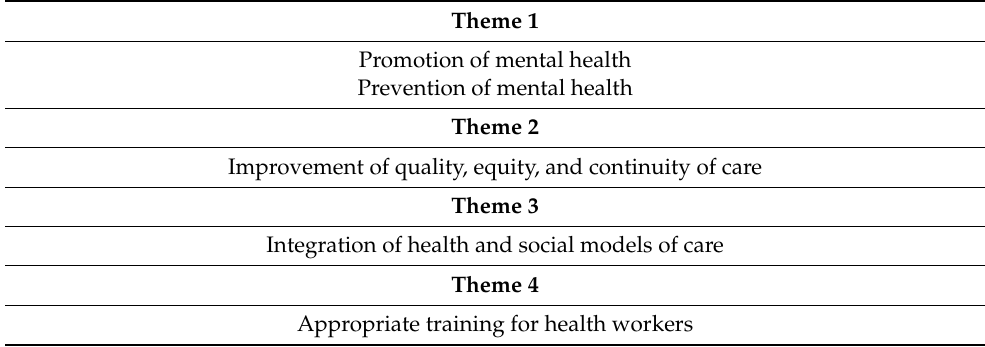
Table 2. Strategic WHO objectives and proposed actions as they apply to